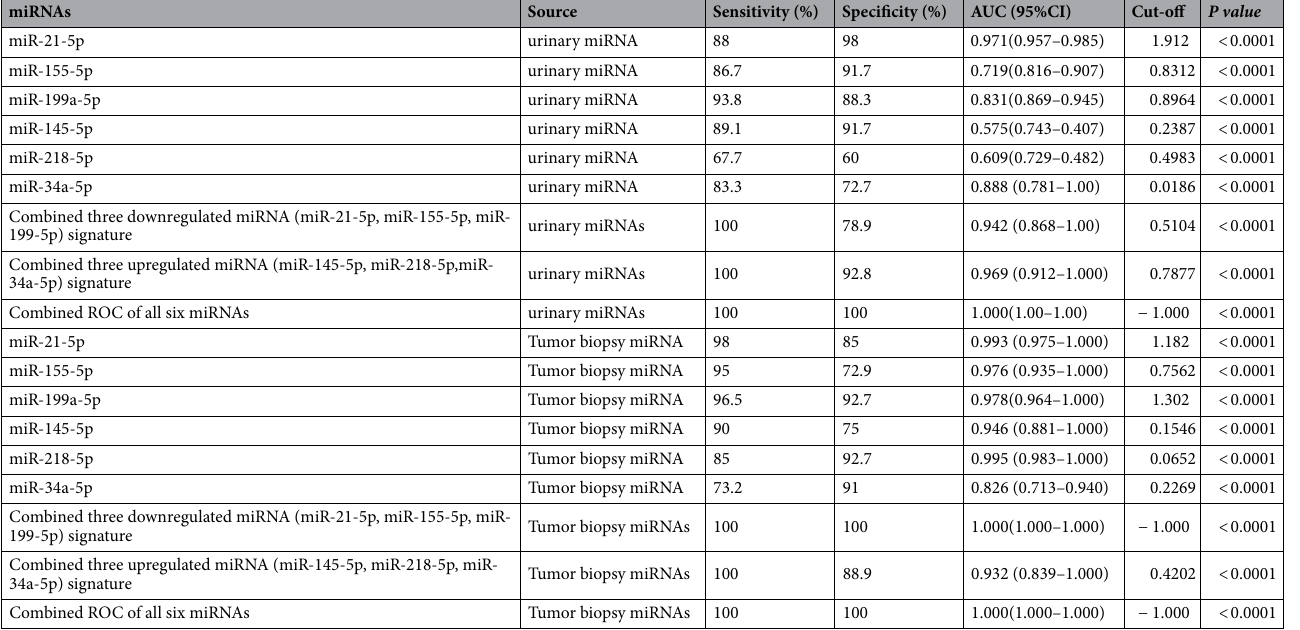
Table 3. Diagnostic performance of miRNAs in cervical cancer patients.